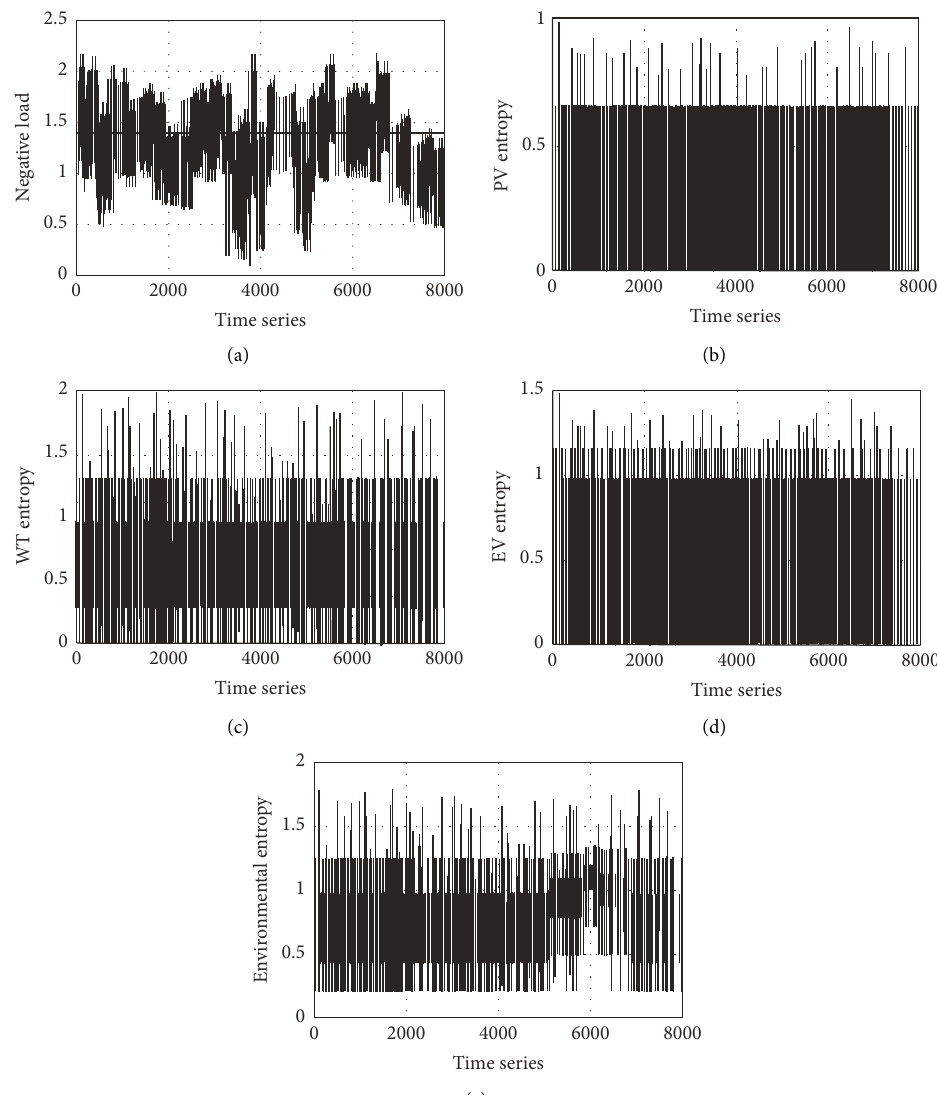
Figure 10: Change curve of the free entropy index, (a) load entropy, (b) PV entropy, (c) WTentropy, (d) EV entropy, and (e) environmental